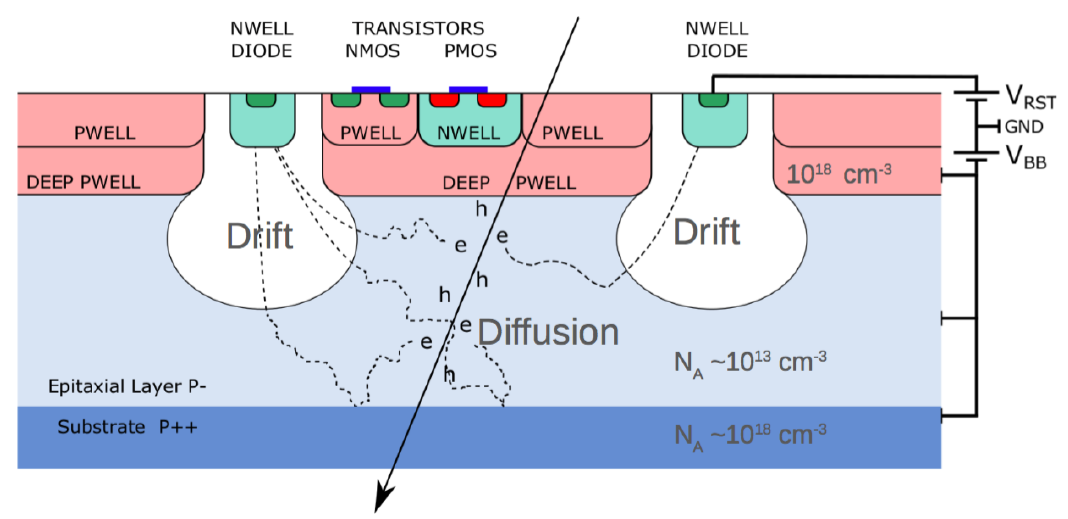
Figure 2. Cross section of an ALPIDE pixel. A charged particle crosses the sensitive volume (high-resistivity epitaxial layer between the substrate and the layer with CMOS transistors) and generates free charge carriers that diffuse across the epitaxial layer until they reach the drift region of a n-well diode, where they are being collected, taken from [4].